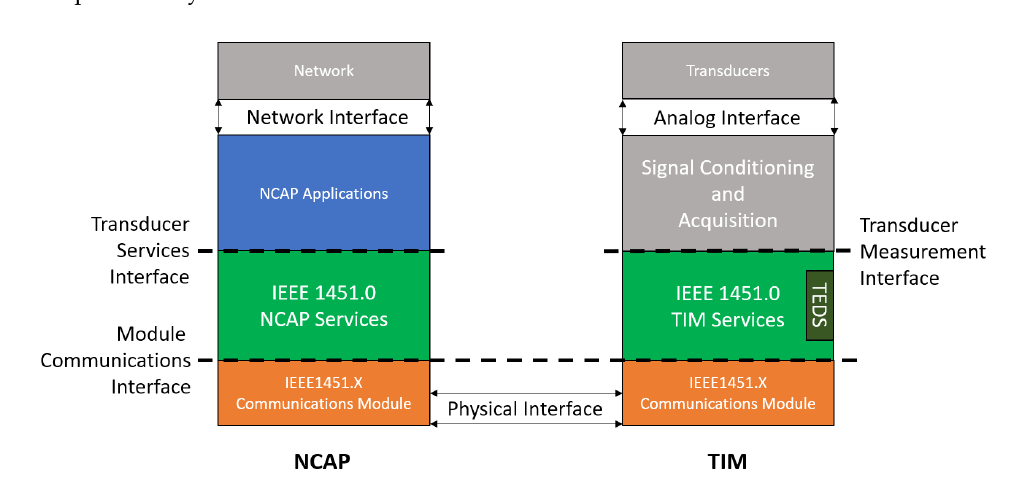
Figure 4. IEEE 1451.0 reference model (adapted from the Standard